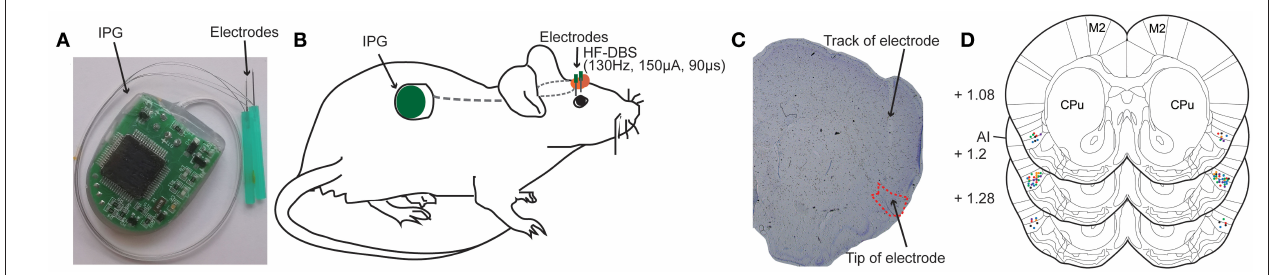
FIGURE 1 | Deep brain stimulation (DBS) device and bilateral electrodes implantation in rat anterior insula (AI). (A) Photograph of the DBS device comprising an implantable pulse generator (IPG) and two electrodes. (B) Schematic view illustrating the electrodes that are secured in the skull over AI and the subcutaneously implanted IPG. (C) A representative rat brain section stained with cresyl violet showing the successfully placed electrode in the AI. (D) Locations of implanted electrodes (colored dots) in the AI of rats included for further analysis ( n = 56). Experiment 1: morphine-DBS-sham (red), n = 11; morphine-DBS (green), n = 13. Experiment 2: morphine-DBS-sham (orange), n = 9; morphine-DBS (blue), n = 11. Open field and novel object recognition tests: DBS-sham (black), n = 6; DBS (purple), n = 6. CPu, caudate putamen. The brain coronal sections are adapted from the atlas of Paxinos and Watson